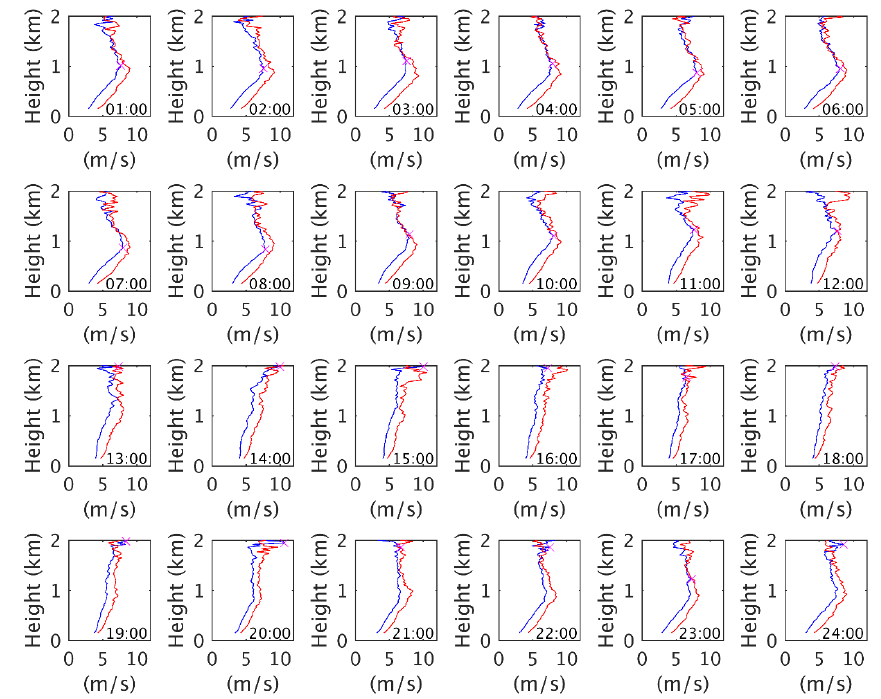
Figure 5. Diurnal vertical profiles of horizontal wind speed at the CUHK (blue) and KP (red) sites. The vertical gradient was shown clearly in the averaged upper air sounding profiles, see Figure 4e. Similar to the LiDAR profiles at 08:00 HKT and 20:00 HKT, the averaged mean vertical profile at 08:00 HKT has a clear vertical gradient with a peak at around 0.80 km, whereas it was not shown in the 20:00 HKT upper air sounding profile. Figure 6 shows the diurnal vertical profiles of prevailing wind direction and the corresponding mean wind speed at the two LiDAR stations. The weaker vertical gradient of horizontal wind speed at the two LiDAR sites between 13:00 HKT and 20:00 HKT was due to the relatively weak northerly wind between 0.8 km and 1.4 km. It is noted that the northerly wind should be blocked by the topography at the north of the two sites.